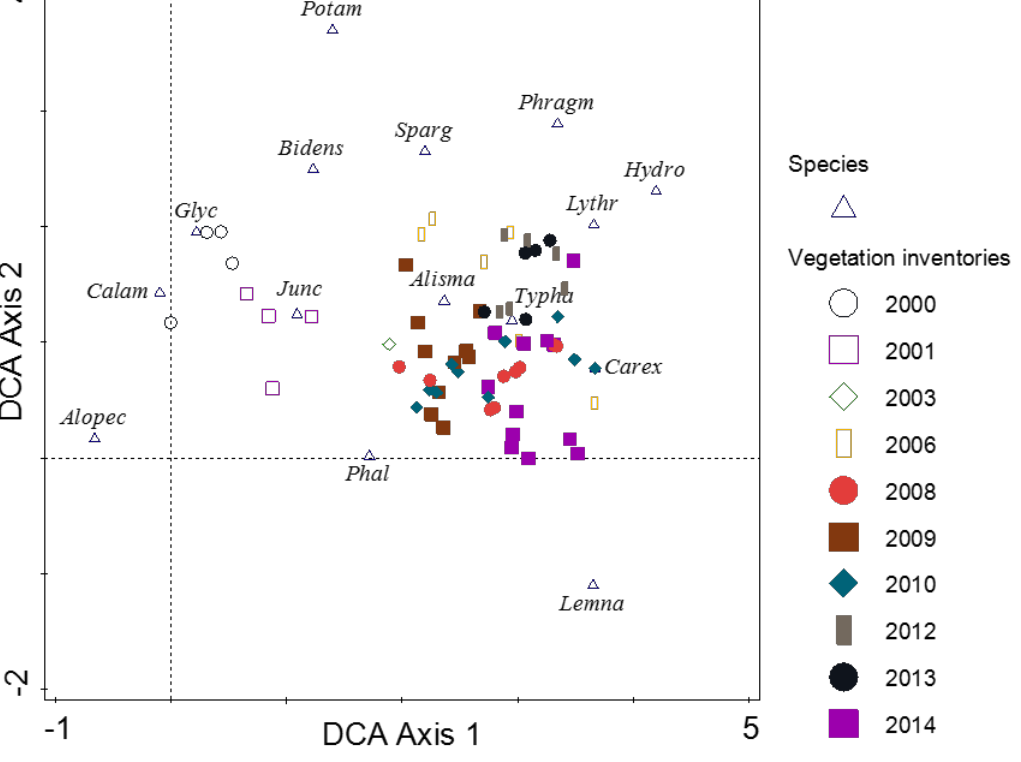
Figure 3. Detrended Correspondence Analysis (DCA) of 69 vegetation relevés in the Västkärr wetland. Empty triangles show the relative species positions. Species with relative weights from 1 % to 100 % are shown. Symbols show relative positions of vegetation relevés according to the year of observation. Scaling of axes is in SD units. Total inertia (variance) is 2.764. Eigenvalues of Axis 1 and Axis 2 are 0.535 and 0.298, respectively. Species abbreviations are shown in Table